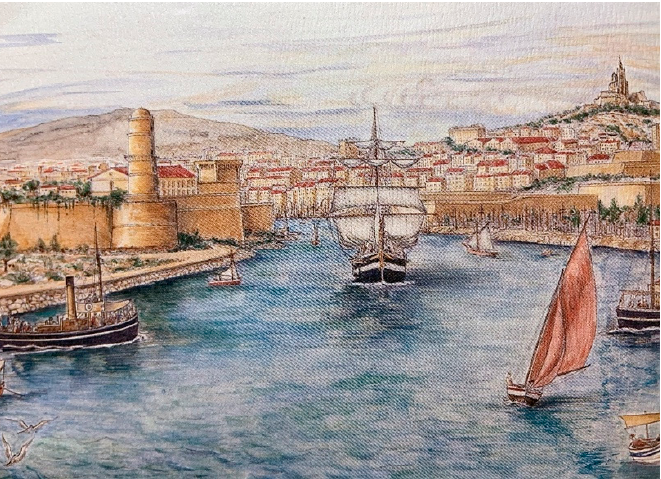
Figure 3. A postcard depicting “Marseille le Vieux Port,” the old port of Marseille, could be found in shops around city in the early 2000s, showing a place defined by its relationship to the sea. Image courtesy of the Regis family.